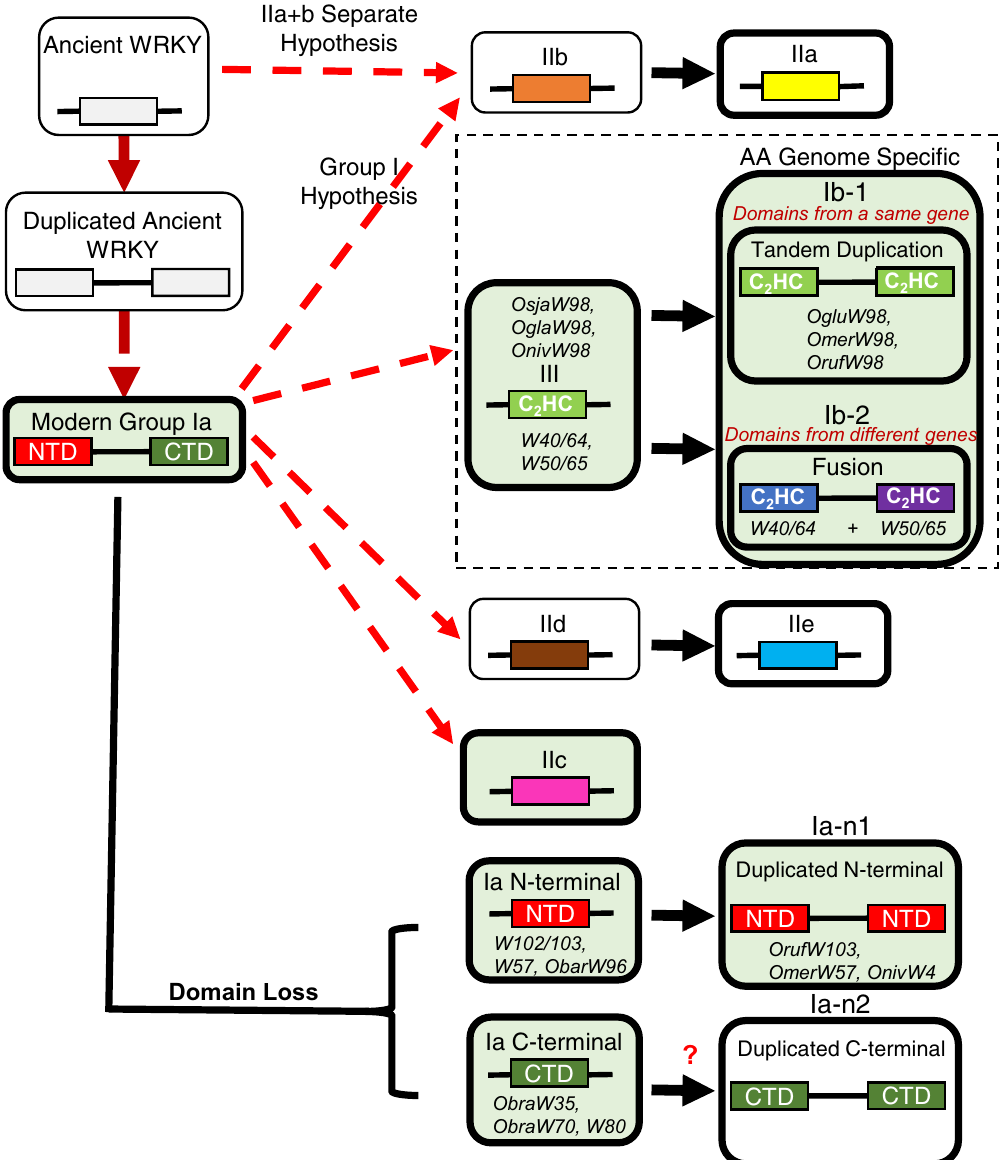
Figure 8. Evolution of the WRKY family through domain duplication and deletion. The figure summarizes how the WRKY family in Oryza is expanding and evolving according to the phylogenetic analysis. Red dashed arrows indicate relationships as we reported previously 6 . Green filled boxes represent new information deduced from our data with specific Oryza WRKY gene examples. WRKY domains in the black dashed rectangle are the C 2 H 2 type while the rest are the C 2 HC type. Tandem duplication of the N-terminal WRKY domain of more ancient Group Ia proteins produces Group Ia-n1. The question mark indicates that the tandem duplication of the C-terminal WRKY domain of more ancient Group Ia to produce Group Ia-n2 is theoretically possible but has not been found in the Oryza genomes we have studied so